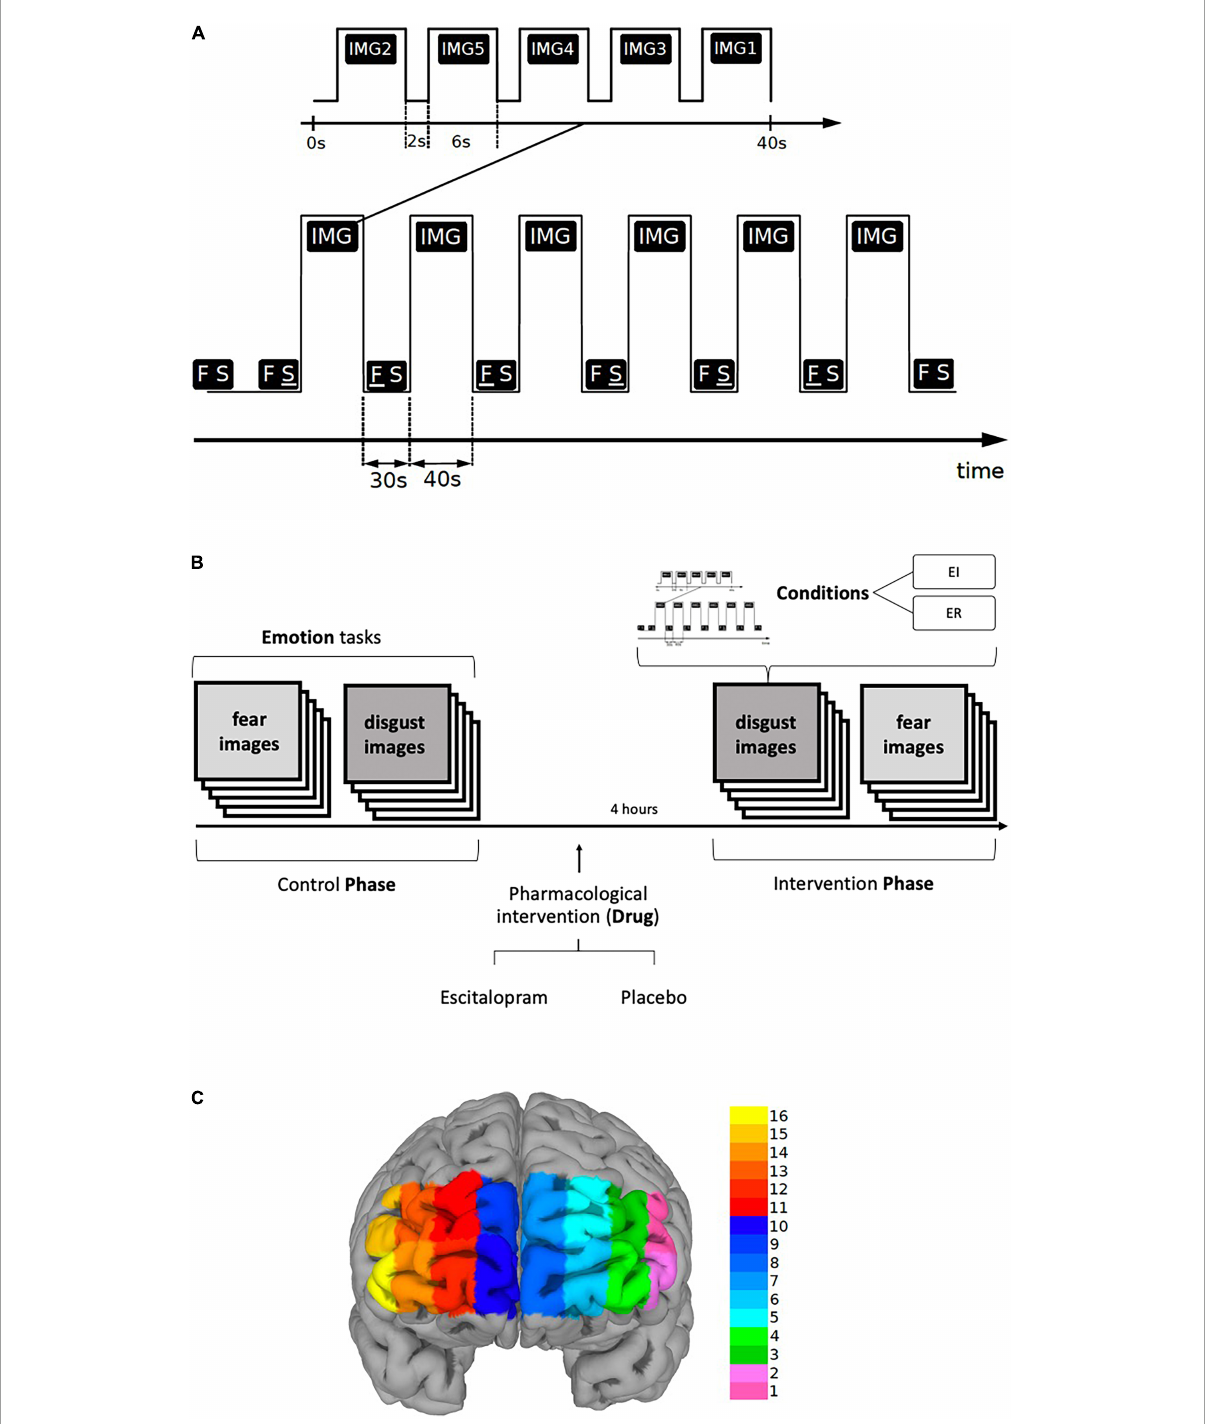
FIGURE1 (A,B) Paradigm timing for each task (fear and disgust). Each task included six blocks of stimuli (IMG), each block was 40-s long and was preceded by a 30-s long period of REST (FS). In each block, five different visual emotive stimuli (pictures IMG1-5) were presented on the screen, each for six seconds, followed by a two-seconds long interval to separate them from each other. Immediately after viewing the pictures, the subjects were asked to score emotion intensity for every image in a scale ranging from 1 to 9 during emotion induction (EI) and emotion regulation (ER). The identical procedure was repeated four hours after the ingestion of escitalopram or placebo (intervention phase). The order of the images, conditions and tasks was randomized. (C) Shows the fNIRS channel locations on the PFC. The data were averaged over left (LPFC, channels 1-6), medial (MPFC, channels 7-10) and right (RPFC, channels 11-16) prefrontal regions to increase signal-to-noise